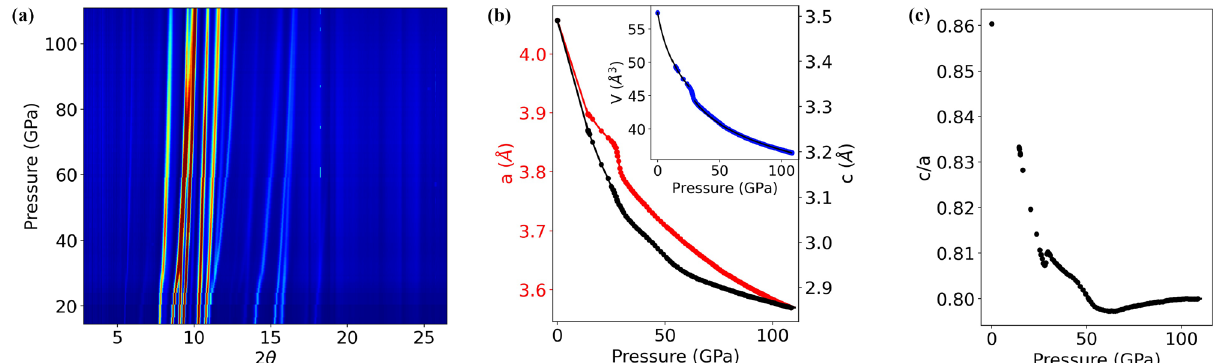
Figure 1. ( a ) Color map of the diffractogram as function of pressure. ( b ) Evolution of the lattice parameters a (red circles, left scale) and c (black circles, right scale) as a function of pressure; the typical error bars for both parameters is around 0.002 Å, smaller than the point size; inset: evolution of the volume as a function of pressure (blue circles) and fit (black lines) using a 3rd order Birch-Murnaghan EOS. Error bar for the volume is 3 less than 0.1Å , smaller than the point size. ( c ) Evolution of the c / a ratio as a function of pressure.